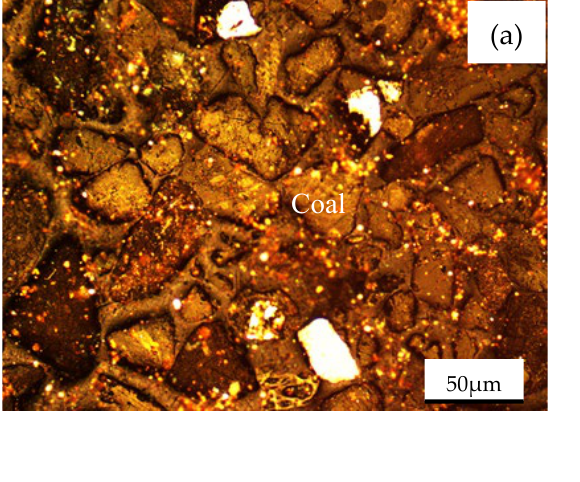
Figure 6. Pore images of the filter cake solidified with epoxy resin and red colorants and their gray- scale value distribution. ( a ) Epoxy resin and yellow colorant; ( b ) epoxy resin and red colorant). As shown in Figure 6, when yellow colorant is added, there is only one main peak in the gray distribution curve of the solidified coal slime filter cake pore image, there is no significant difference between the gray values of coal particles and pores, and the accuracy of image binary segmentation is poor. When red colorant is added, there are two peaks in the grayscale curve of the pore image of solidified slime filter cake, and there are signifi- cant differences between the two peaks, indicating that the gray value of coal particles and pores is significantly different. Therefore, the use of red colorant to solidify filter cake can achieve accurate segmentation of coal particles and pores.